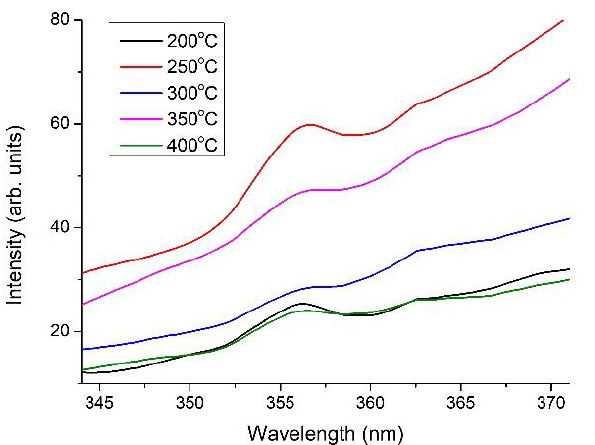
Figure 10. PL spectra in the 343 – 371 nm wavelength range of the 1.0 wt.% WZO films grown at 200 – 400 °C.